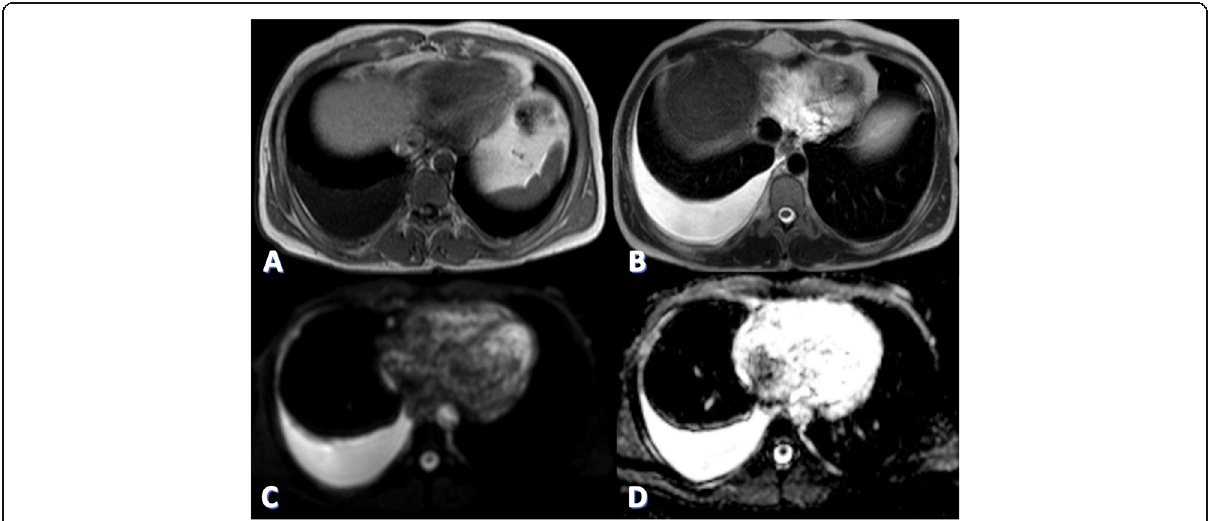
Fig. 1 a Axial T1 WI and b axial T2 WI showing right moderate pleural effusion eliciting low T1 and high T2 signal intensities. c DWI and d ADC map showing no evidence of diffusion restriction being bright on DWI and ADC map (ADC mean = 3.14 × 10 − 3 mm 2 /s). Ultrasound-guided